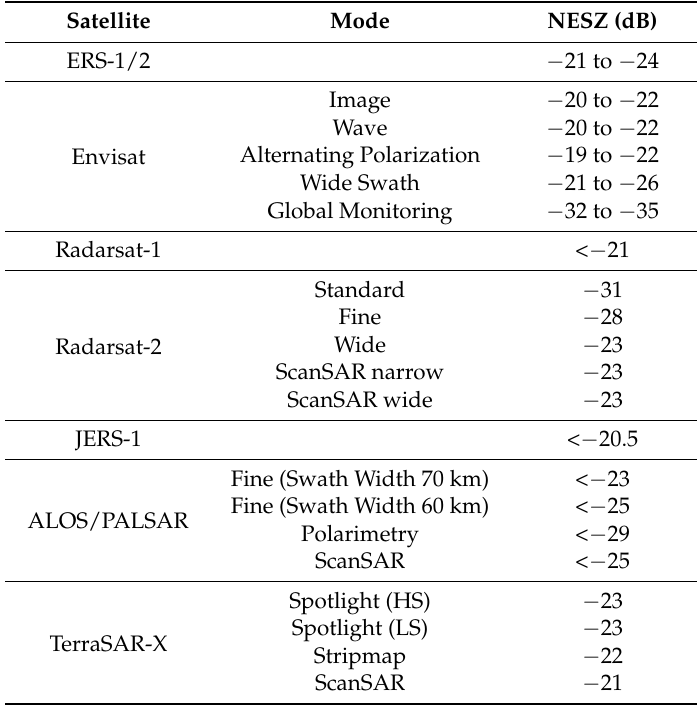
Table 1. Noise equivalent sigma zero (NESZ) values of typical spaceborne synthetic aperture radar (SAR)